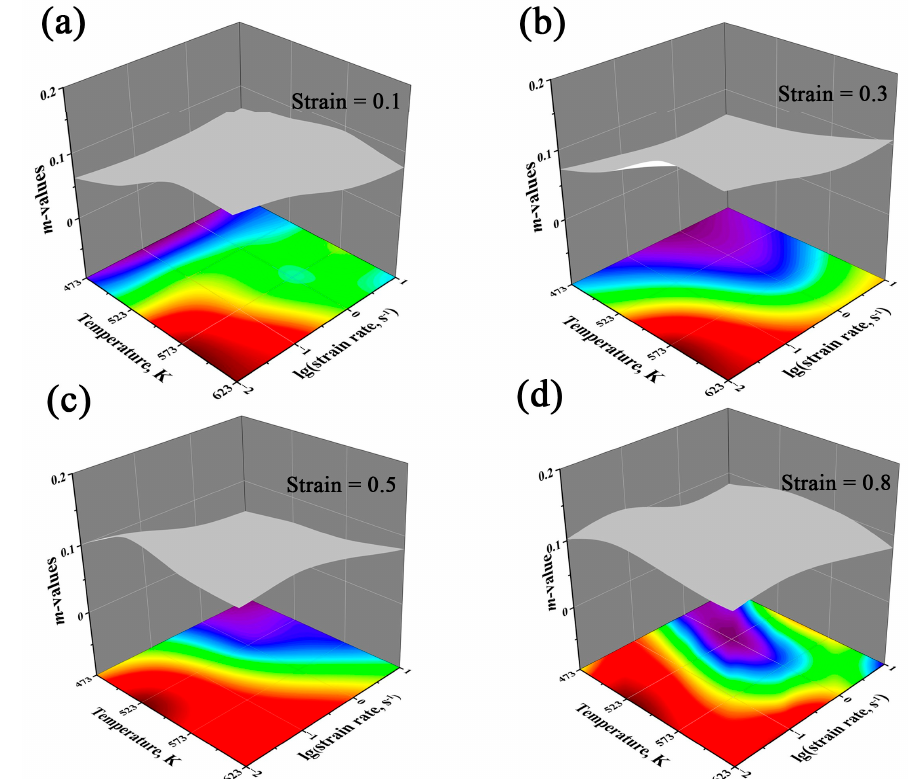
Figure 7. The 3D response surface of m -value on strain rate and temperature under different strains: ( a ) 𝜀 = 0.1, ( b ) 𝜀 = 0.3, ( c ) 𝜀 = 0.5, ( d ) 𝜀 = 0.8, respectively. The processing maps of Mg-3Bi alloy under different strains (0.1, 0.3, 0.5, 0.8) are shown in Figure 8. The numerical value in the figure represents the percentage of power dissipation factor under different deformation conditions, and the same value is repre- sented by contours. The yellow shadow area represents the rheological instability areas, where the ξ value is negative. It can be seen that the value of η basically increased with the increase of deformation temperature and the decrease of strain rate. As shown in Figure 8, the instability region was remarkably different under specific strain, indicating that the strain was more sensitive to the instability region. When the strain was 0.1, the instability domain was concentrated in the medium temperature − low strain rate domain and the high temperature − medium strain rate domain. With the strain increased to 0.2, the insta- bility region was located in the low temperature-low strain rate region and the medium temperature − low strain rate domain. With the further increase of strain, as shown in Figure 8c,d, the instability region was transformed from a low temperature − low strain rate zone and high temperature − high strain rate domain to a part (i.e., high temperature − high strain rate